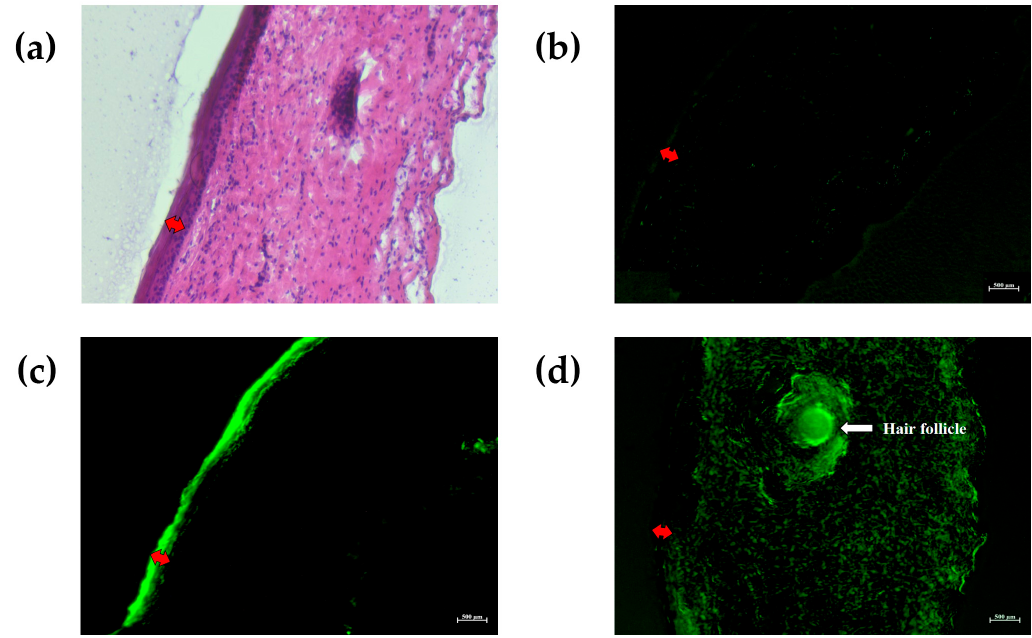
Figure 6. Fluorescence images of fluorescein distribution through the porcine skin samples; ( a ) a phase contrast image of the skin sample observed under a regular microscope; fluorescent images of the porcine skin sample treated with ( b ) PBS, pH 7.4; ( c ) fluorescein solution at 0.1% ( w / v ); and ( d ) NLC_F. Red arrows show the boundary of the epidermis layer. Abbreviations: NLC_F, fluorescein-loaded NLC.